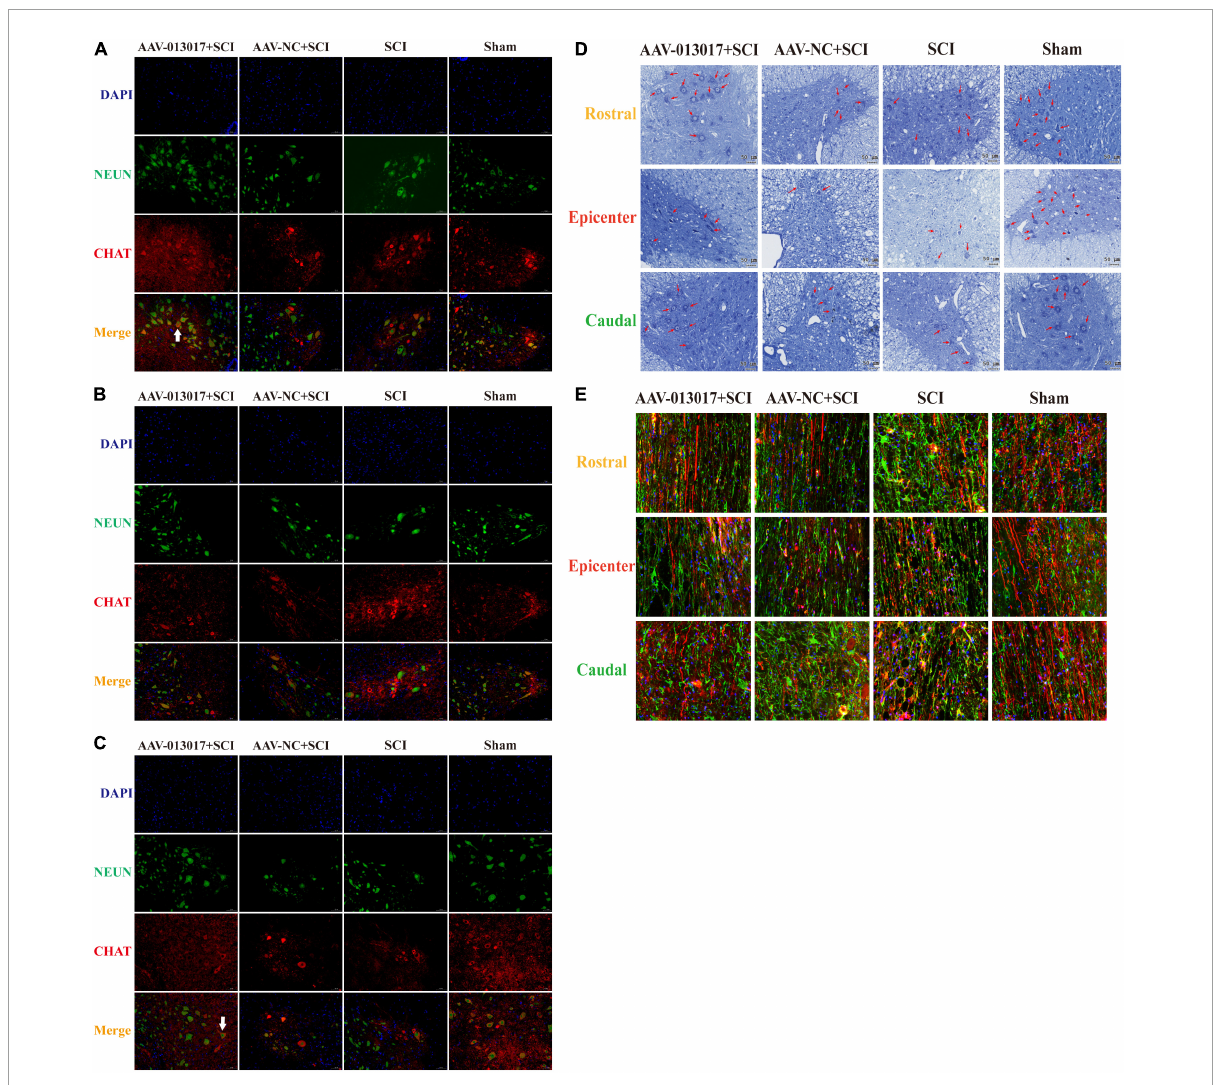
FIGURE4 Inhibition by rno-circRNA-013017 of descending axonal degeneration at 6 weeks after SCI. (A) In the rostral adjacent segment, neurons marked by NeuN and motor neurons marked by ChAt in the anterior horn area were shown in all groups. The white arrow indicates a typical motor neuron with an irregular cell body, nucleus, axon, dendrite, and other cell structures ( n = 5 per group). (B) In the epicenter, only a few normal neurons and motor neurons in the anterior horn area were seen in the three groups subjected to SCI ( n = 5 per group). (C) In the caudal adjacent segment, neurons marked by NeuN and motor neurons marked by ChAt in the anterior horn area were observed in all groups. The white arrow indicates a typical motor neuron with an irregular cell body, nucleus, axon, dendrite, and other cell structures ( n = 5 per group). (D) Nissl bodies indicated by red arrows in the anterior horn area were seen in all groups ( n = 5 per group). (E) The density of descending axons of spared white matter marked by biotin dextran amine (BDA) (red lines) and astrocytes marked by GFAP (green points) are shown ( n =